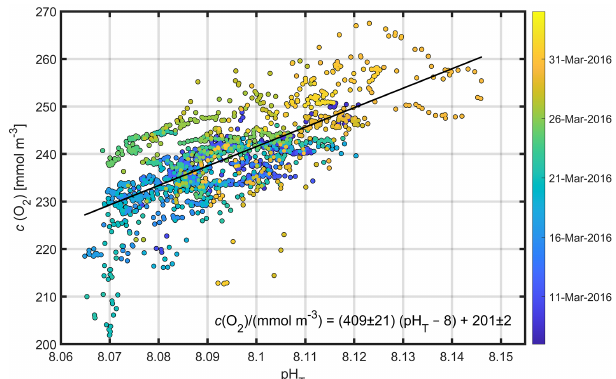
Figure 3. Glider pH T against glider c( O 2 ) and coloured by time for all points within the mean euphotic layer (top 46m). The linear fit and corresponding equation between c (O 2 ) and pH T − 8 are also